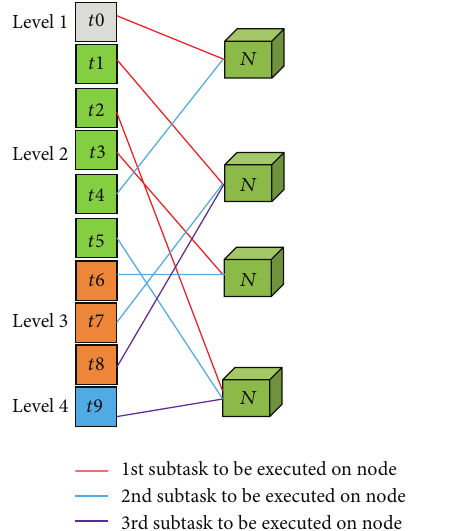
Figure 3: The sequence in which subtasks of 𝑡 , assigned to the same node, will be